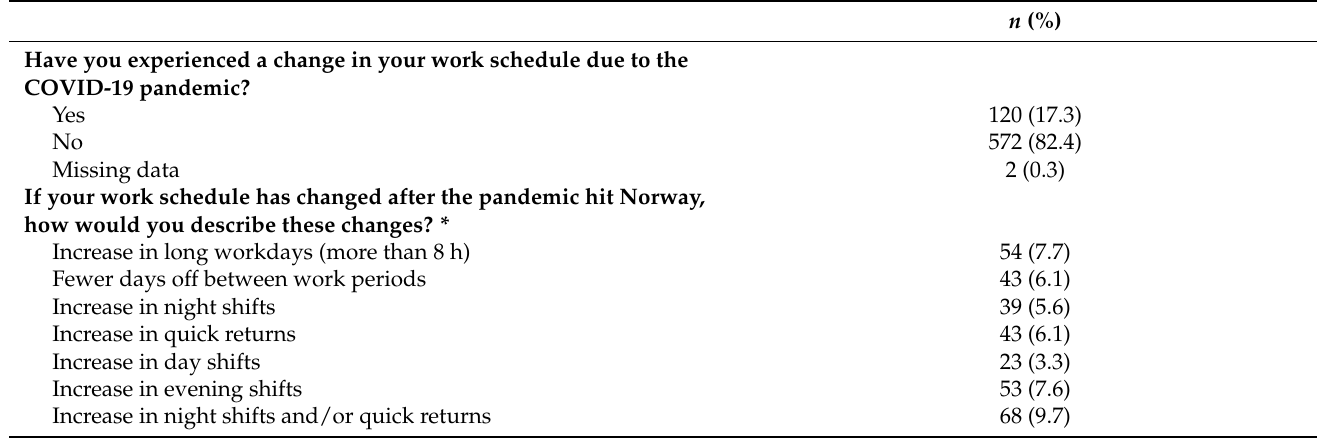
Table 2. Overview of how many participants reported experiencing changes in their work schedule during the COVID-19 pandemic ( n =